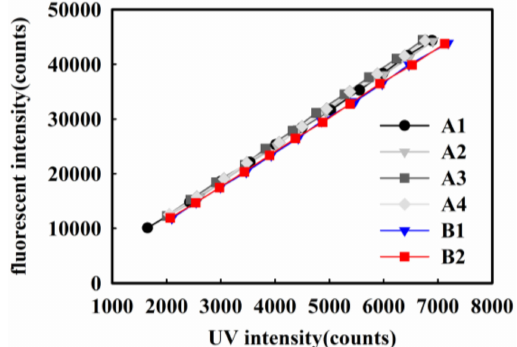
Figure 11. The response of the output intensity of UVOFS versus UV stimulation repeated in 6 cycles to establish the repeatability of the sensor.